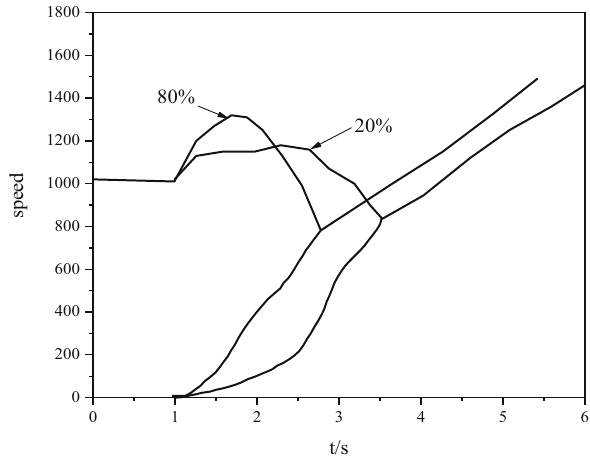
Figure 2: Simulation results of di ff erent throttle positions under fl at road starting conditions.